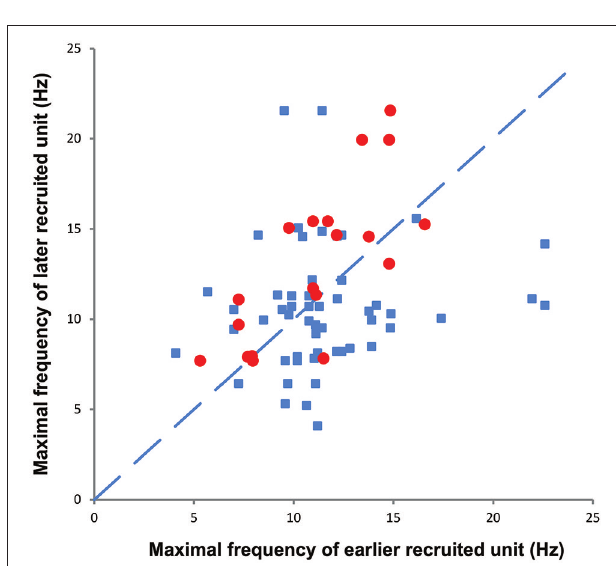
FIGURE 7 | The maximal firing frequency of all motor unit pairs obtained during spasms (blue) . Later recruited units had lower, similar, or higher maximal firing rates than earlier recruited units. The red symbols refer to motor unit pairs that display a moderate ( R 2 > 0.3) to high rate-rate correlation during